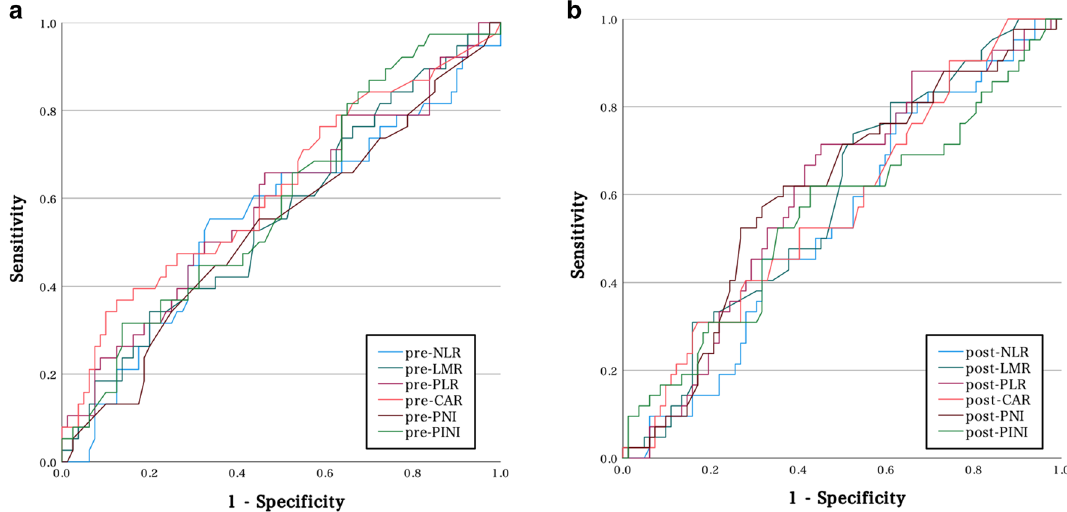
Figure 1. Receiver operating characteristic (ROC) curves for progression-free survival (PFS) according to the pre- and post-treatment